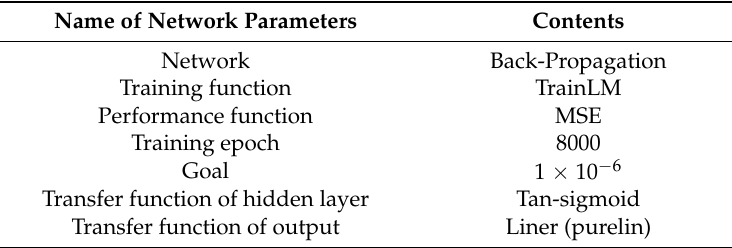
Table 3. Settings of training parameters for the neural